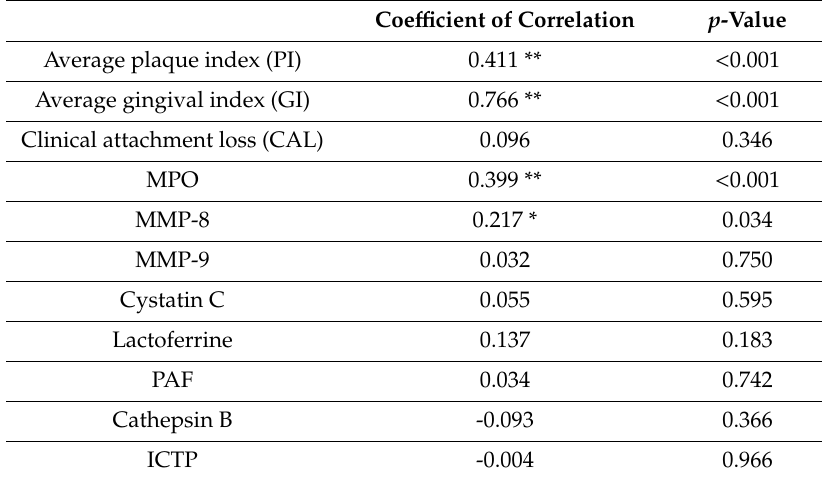
Table 2. Correlation of clinical parameter and biomarkers with number of BOP